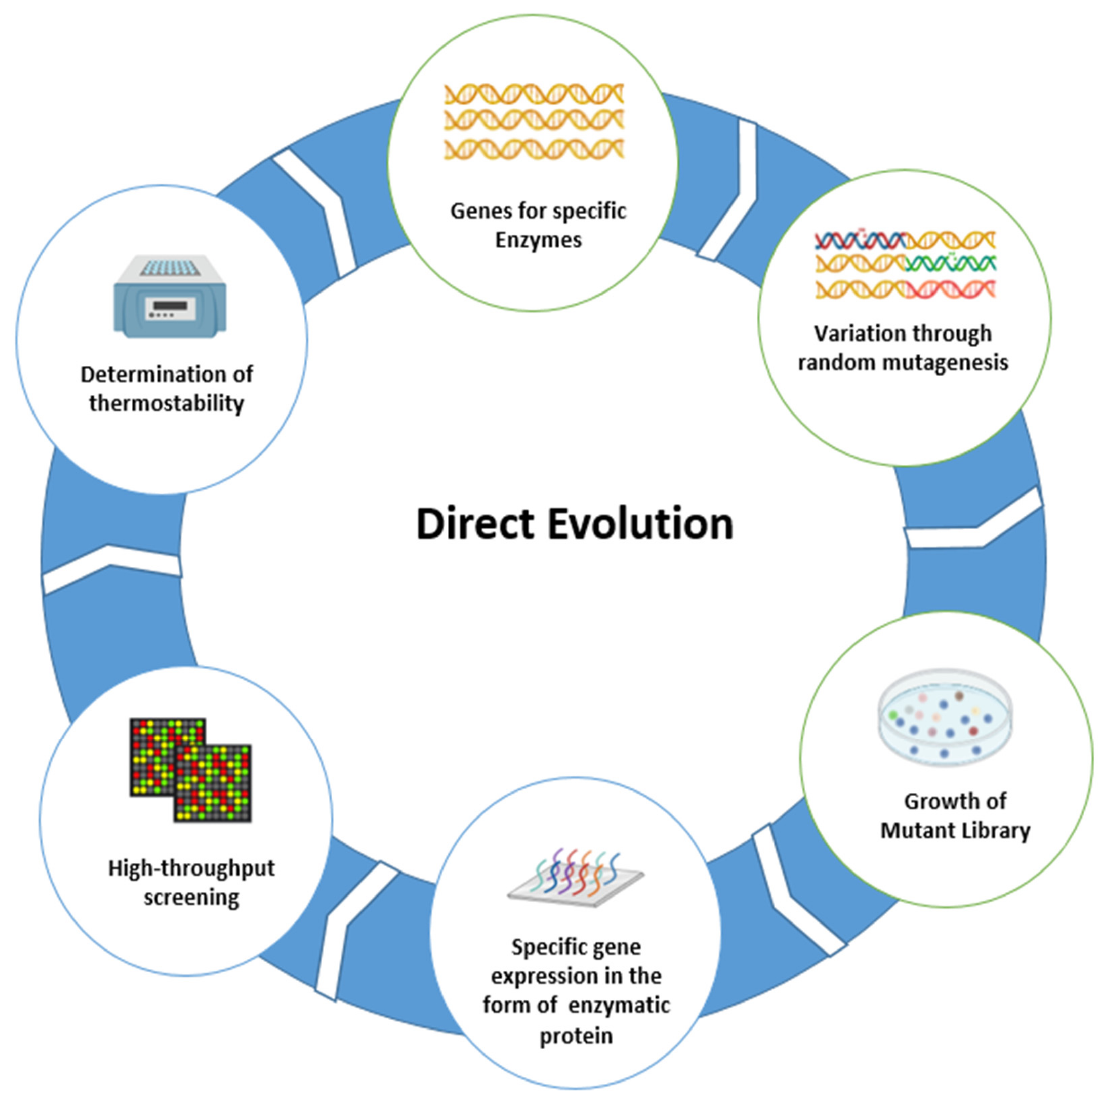
Figure 2. Schematic representation of direct evolution steps, created by https://biorender.com web tool.